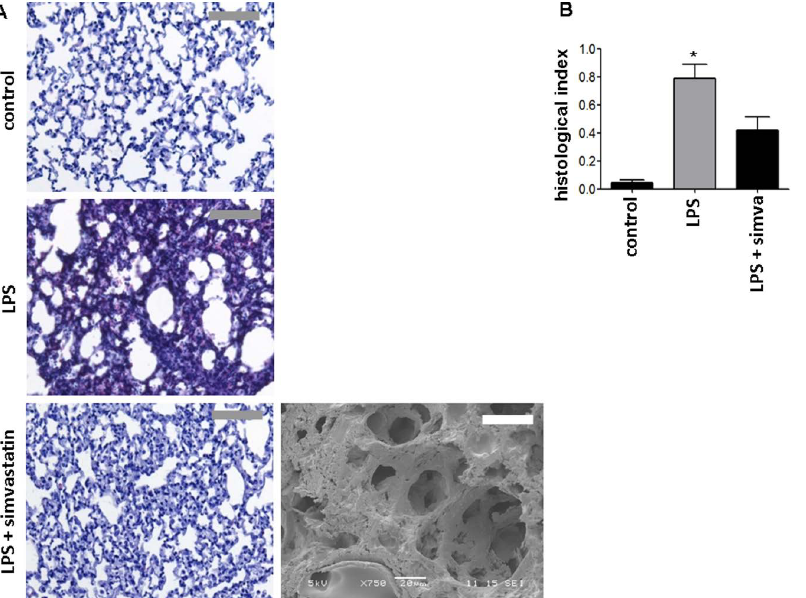
Figure 2. Simvastatin prevents LPS-induced structural changes in the lung tissue. Representative histological (left) and scanning electron microscopic (right) images of lungs from mice treated as indicated. Scale bars indicate 50 m m for scanning electron microscopy and 250 m m for histology. Quantification of histological lung sections (bottom) (n=4 for each bar). Statistical significance was tested using ANOVA with Newman- Keuls Multiple Comparison test. * indicates significant difference compared to LPS-treated animals.